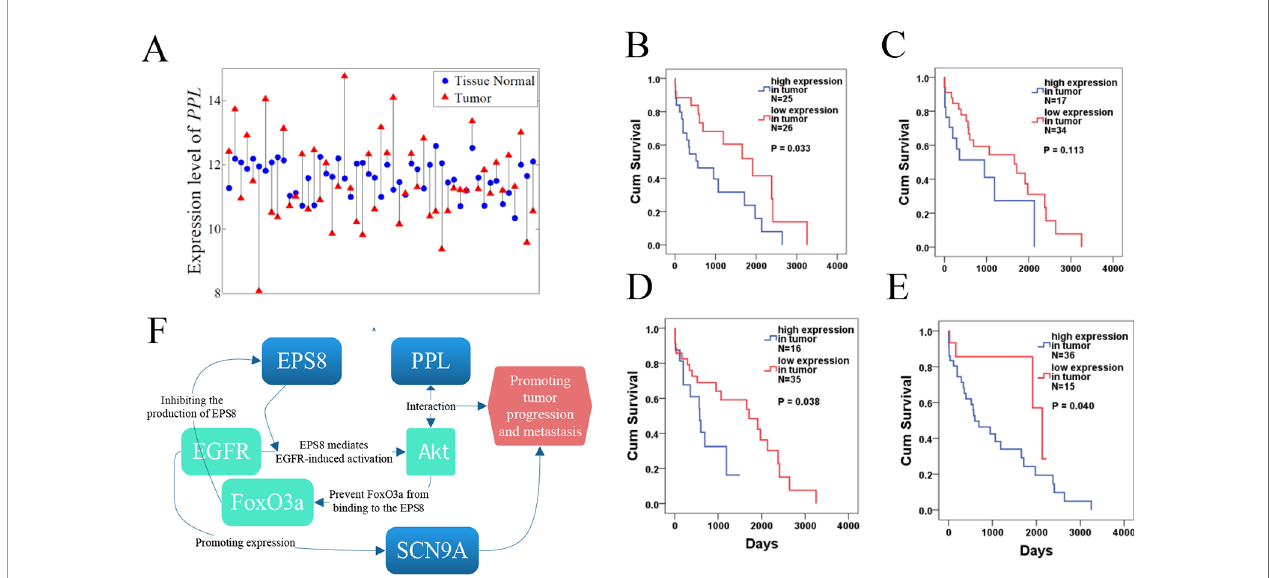
FIGURE 9 | Survival analysis of PPL, SCN9A, EPS8, and MTAP for the lung squamous cell carcinoma (LUSC) dataset. (A) Expression pattern of PPL in LUSC. Tumor samples and paracarcinoma tissue samples from the same patient are connected by a black line. (B – E) Results of survival analysis for PPL, SCN9A, EPS8, and MTAP. (F) Functional network for PPL, SCN9A, and